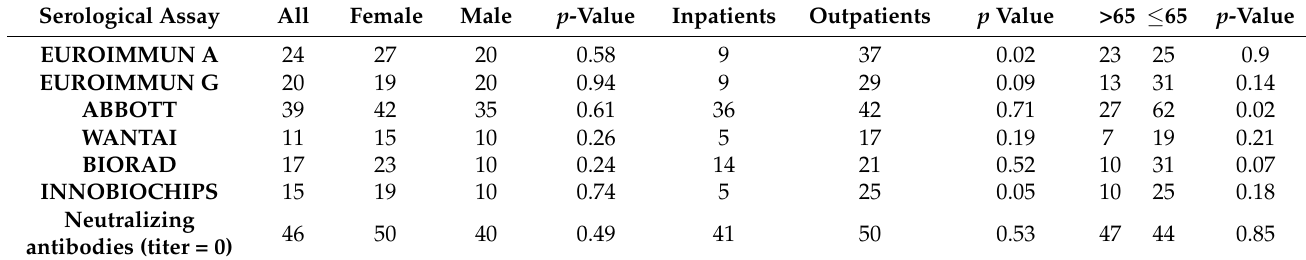
Table 2. Percentage of reversion at Day 180 post-PCR.